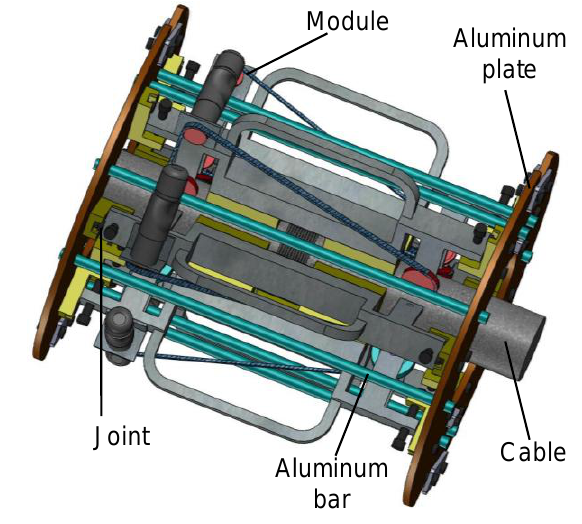
Figure 10. Structure of the